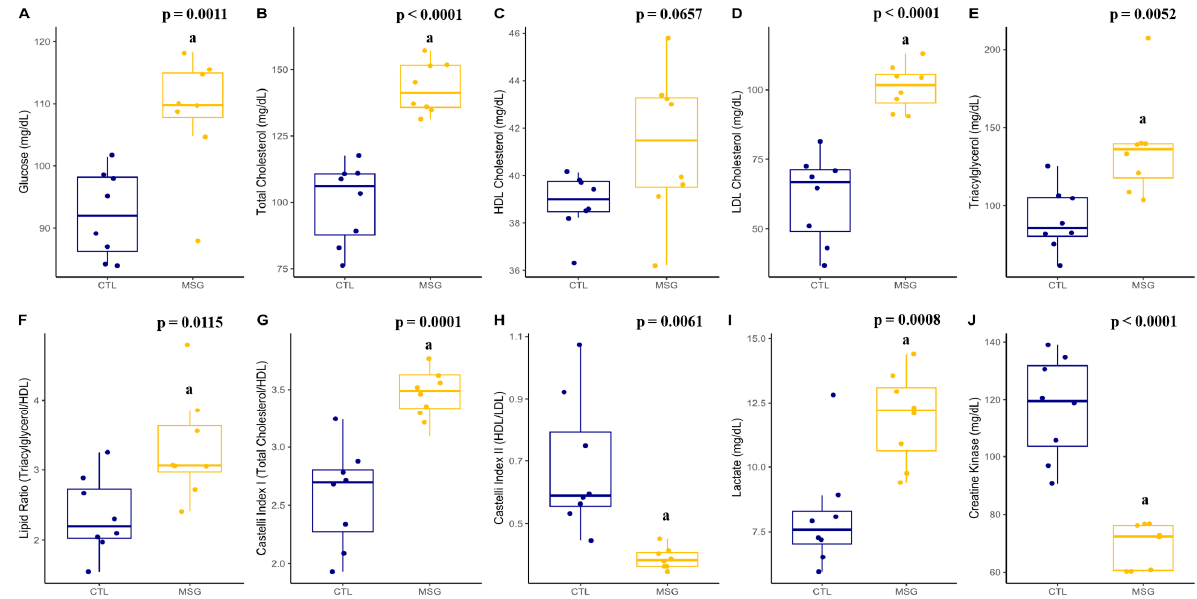
Figure 9. Graphs related to plasmatic profile in PND142: ( A ): glucose (mg/dL); ( B ): total cholesterol (mg/dL); ( C ): HDL cholesterol (mg/dL); ( D ): LDL cholesterol (mg/dL); ( E ): total triacylglycerols (mg/dL); ( F ): lipid ratio (total triacylglycerols/HDL); ( G ): Castelli index I (total cholesterol/HDL); ( H ): Castelli index II (HDL/LDL); ( I ): lactate (mg/dL); ( J ): creatine kinase (mg/dL). The CTL is represented in blue and the MSG group is represented in yellow. The letter a represents the difference between the MSG group when compared to the CTL group. All data: Student’s t -test.